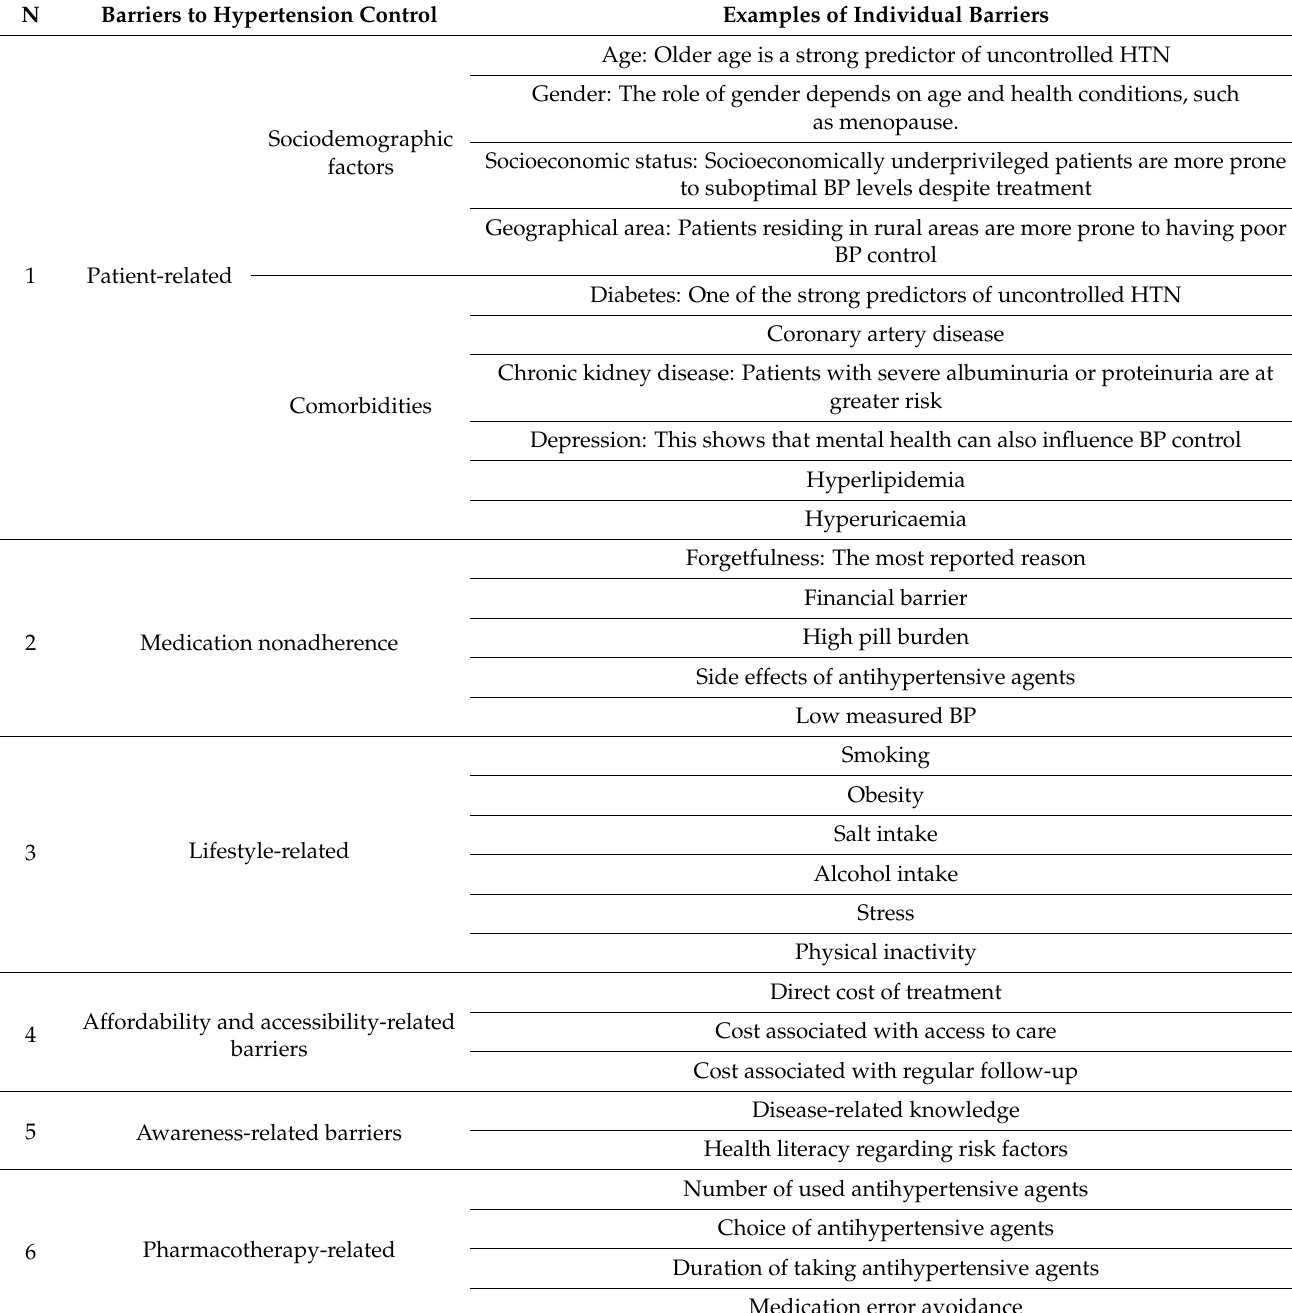
Table 2. Overview of common barriers to optimal hypertension control and its